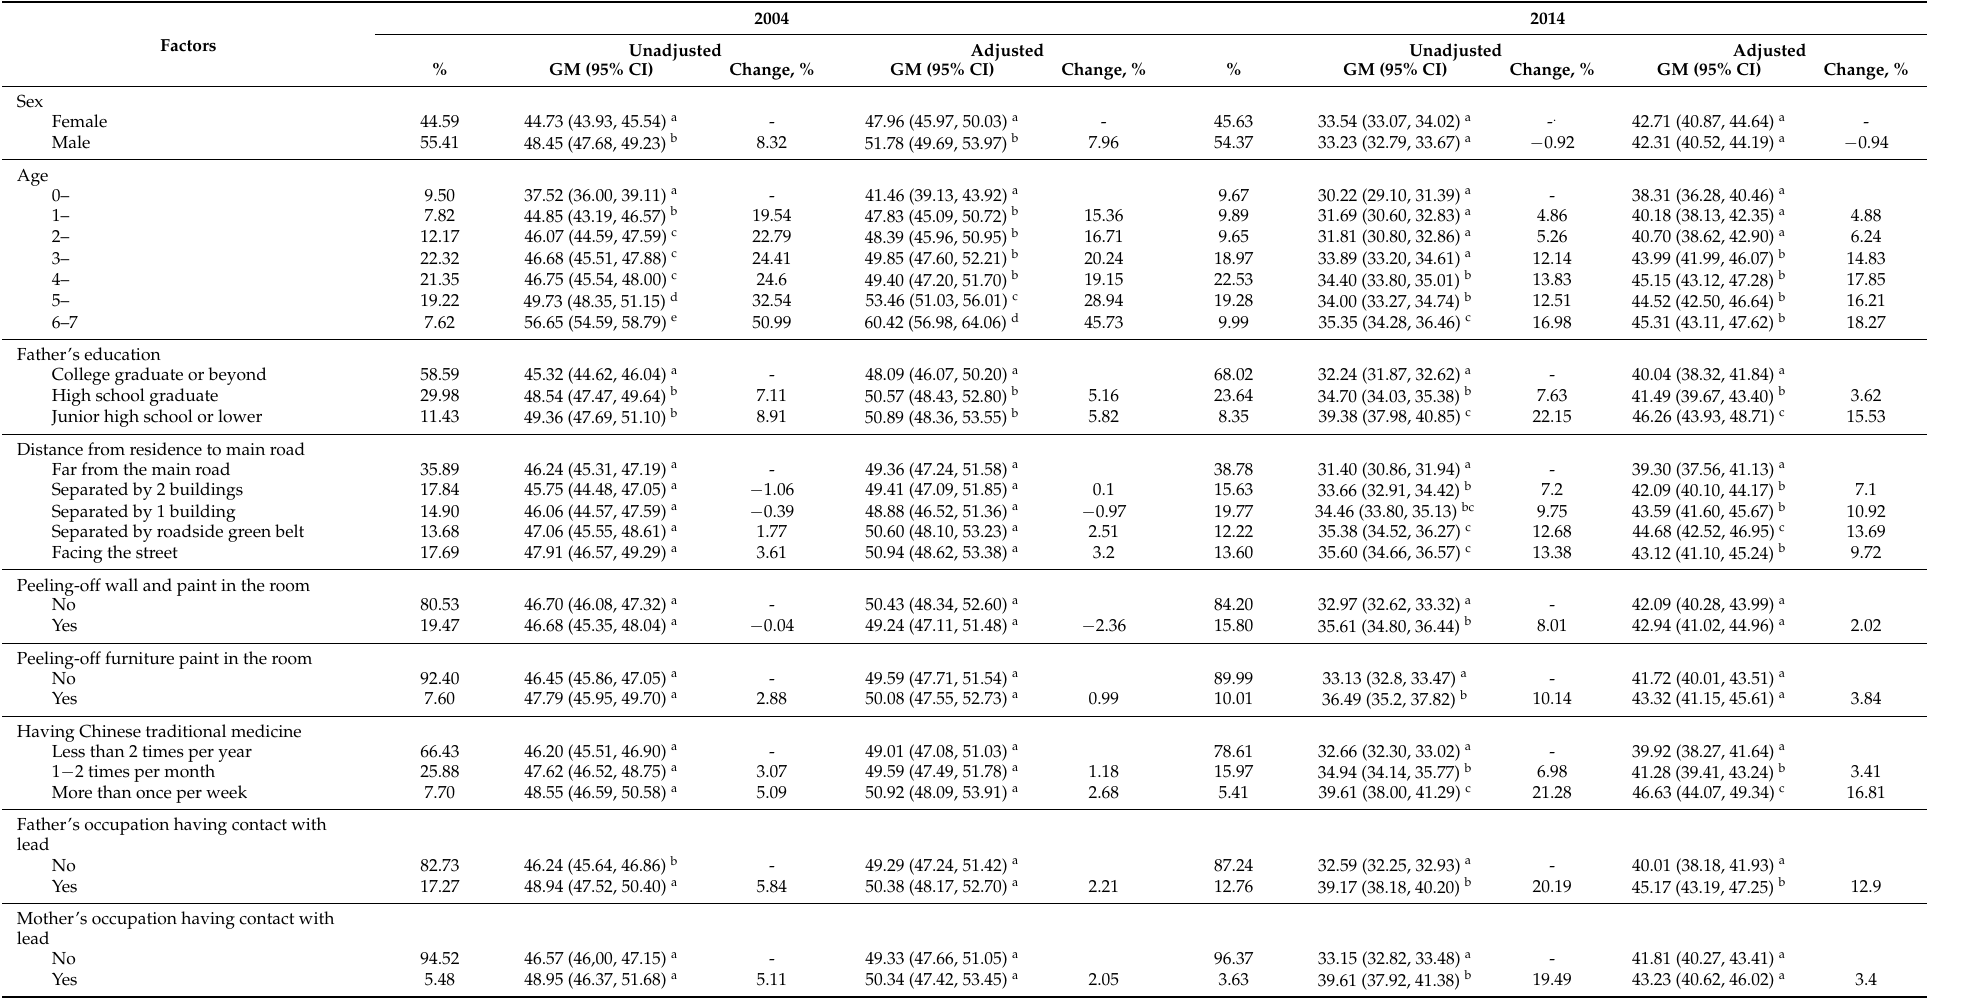
Table 2. Children’s blood lead levels ( µ g/L) by socioeconomic and behavioural factors for two time